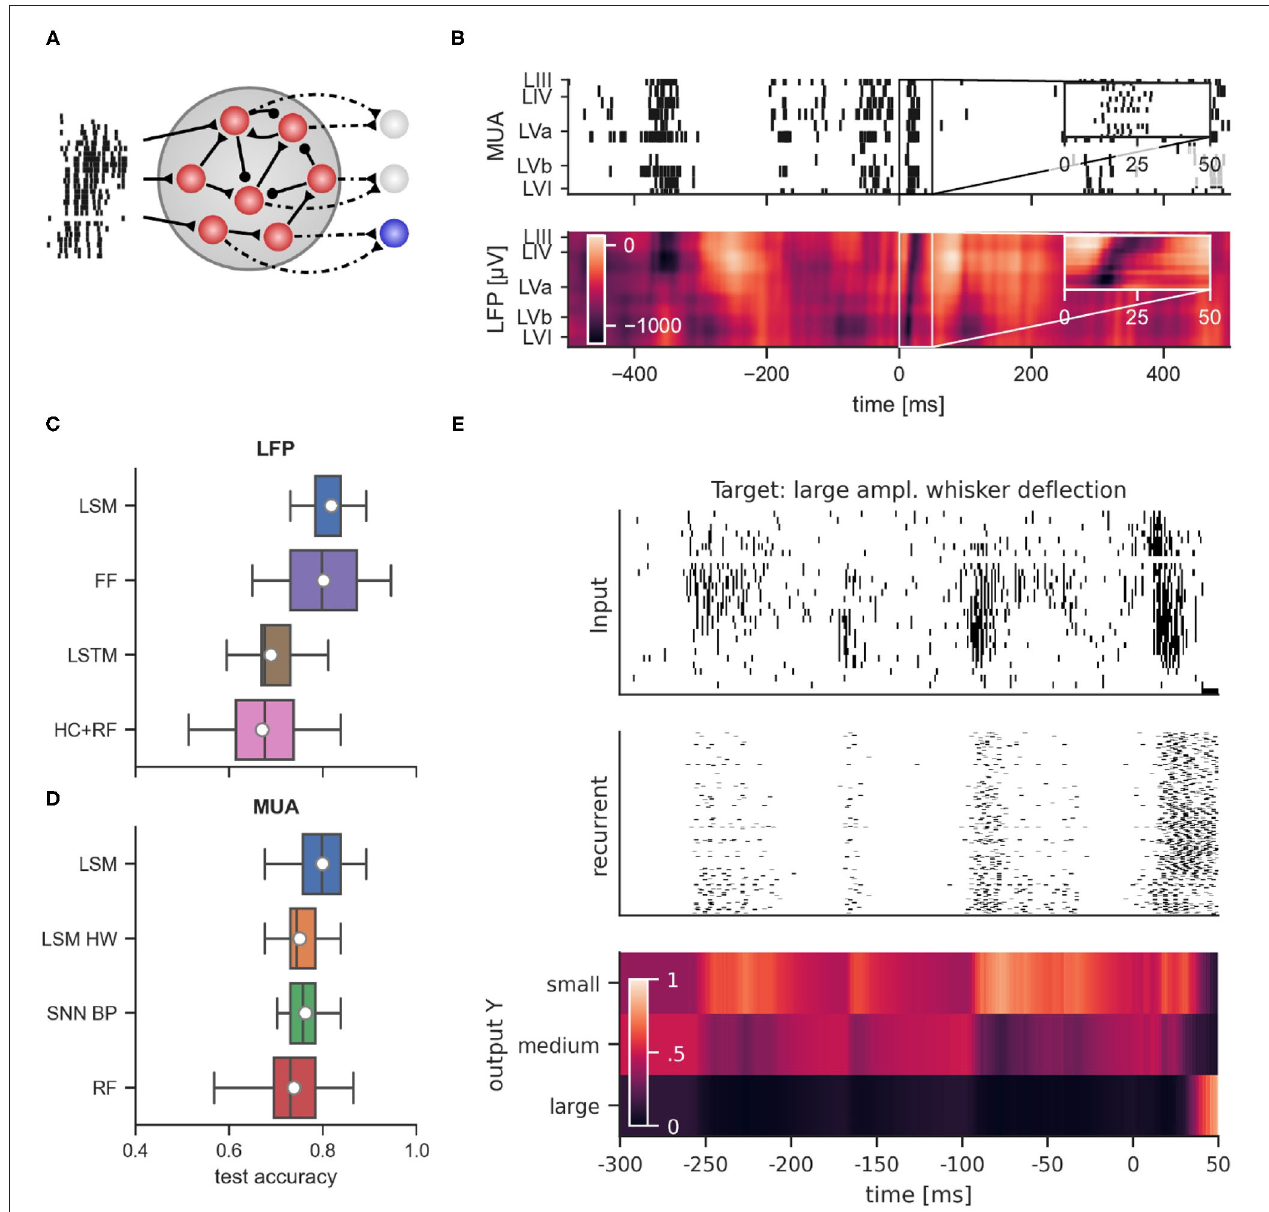
FIGURE 4 | (A) General connectivity scheme of the recurrent spiking neural networks used in simulation. (B) Example of multi-unit activity (top) and the corresponding LFP trace (bottom) in response to a large whisker stimulation at time 0. Performance comparison of classifiers using LFP data from layer IV (C) and MUA data (D) . LSM, Liquid state machine; FF, feed-forward neural network; LSTM, long short-term memory network; HC+RF, handcrafted features with random forest classifier; LSM HW, liquid state machine with hardware constraints; SNN BP, recurrent spiking neural network trained with backpropagation through time; RF, random forest. (E) Dynamics of a recurrent spiking network after training with BPTT when multi-unit activity was presented. From top to bottom: raster plot of MUA input, response of regular spiking neurons, and activation of readout units for large, medium and small whisker deflection amplitudes. Shown is multi-unit activity and network response relative to stimulus onset starting at 300 ms before stimulus onset. Note the prominent spontaneous events which induce significant but temporally decaying responses in the SNN.